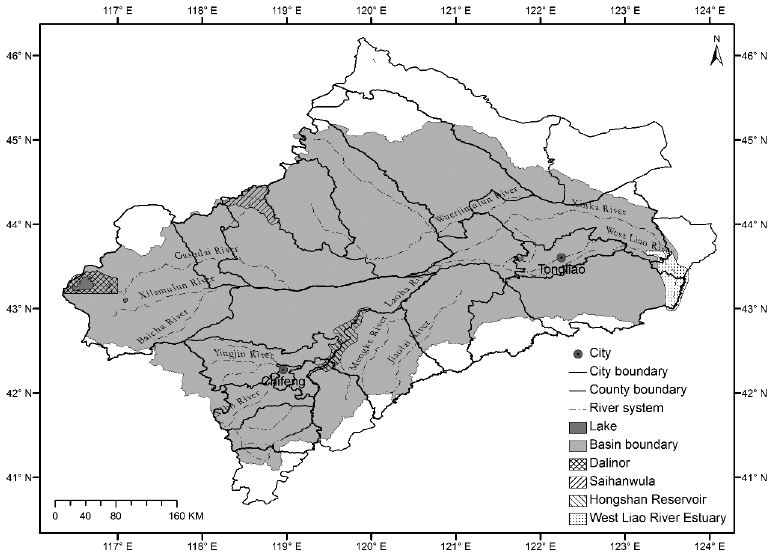
Figure 1. The location of the study